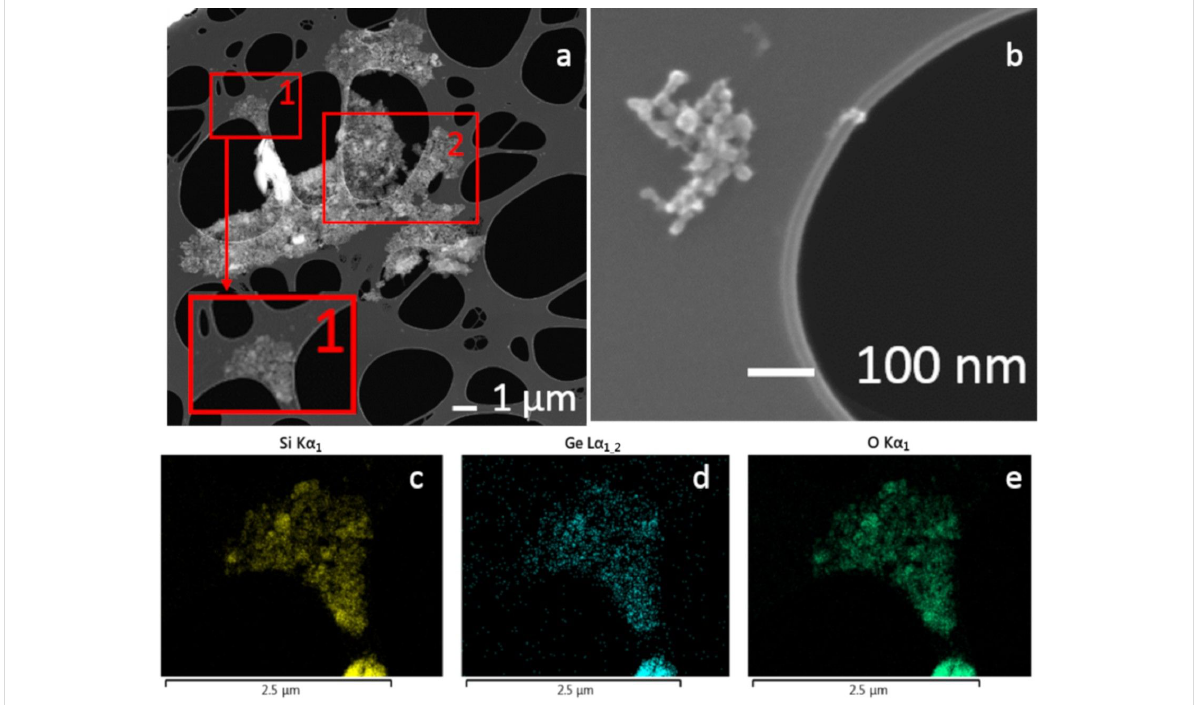
Figure 1: Sample A (SiO 2 +Ge, 33 mJ/pulse); a) SEM image of an agglomerate/aggregate of nanoparticles, inset zoom of the square 1; b) SEM image of a small group of nanoparticles; c), d) and e) EDX mapping of the Si K α 1 , Ge L α 1,2 and O K α 1 lines, respectively, recorded in the zone indicated as square 1 in panel a.